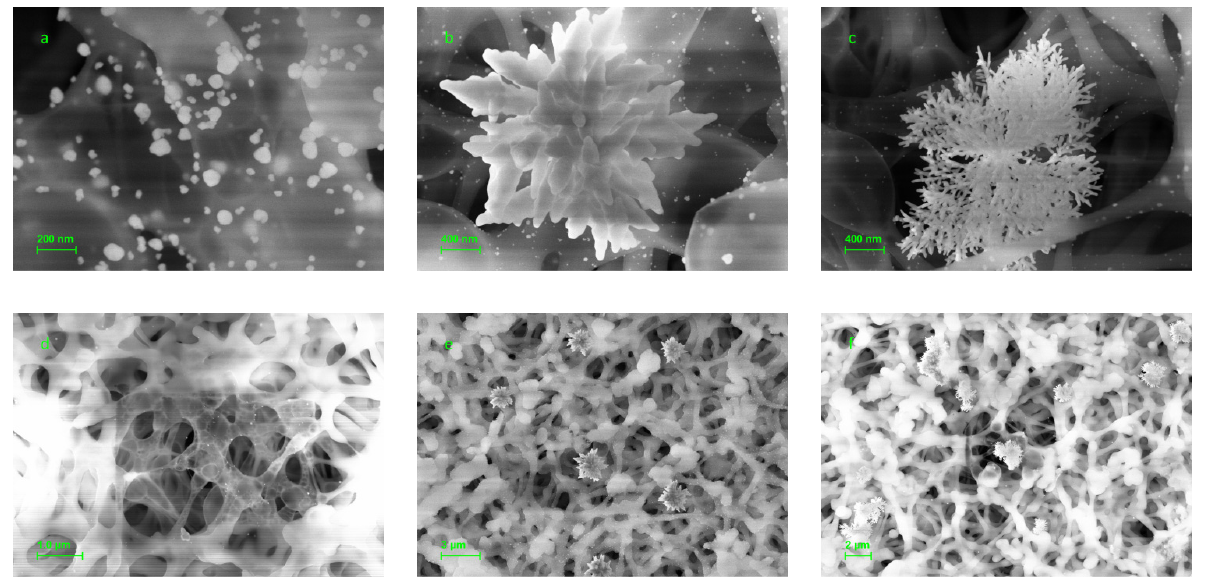
Figure 6. SEM images of the specific and control spots after hybridization of the membrane microarray with 150 pM of target oligonucleotide followed by enhancement procedure at pH range from 5.5 to 7.0. Specific ( a ) and control ( d ) spots after enhancement at pH 5.5; specific ( b ) and control ( e ) spots after enhancement at pH 6.0; specific ( c ) and control ( f ) spots after enhancement at pH 7.0.